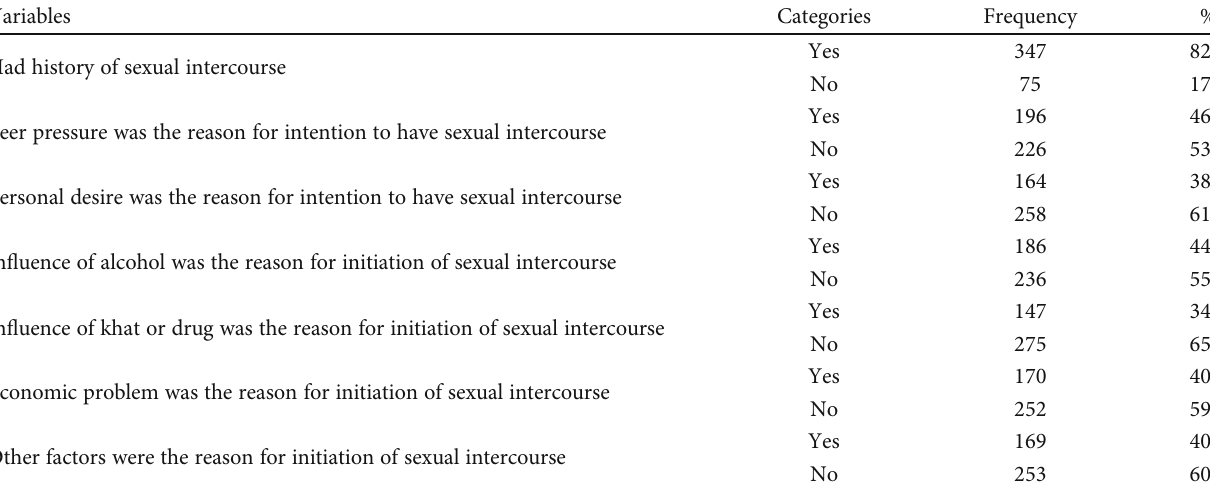
Table 2: Behavioral characteristics of female students at Hawassa University, SNNPR, Ethiopia, April